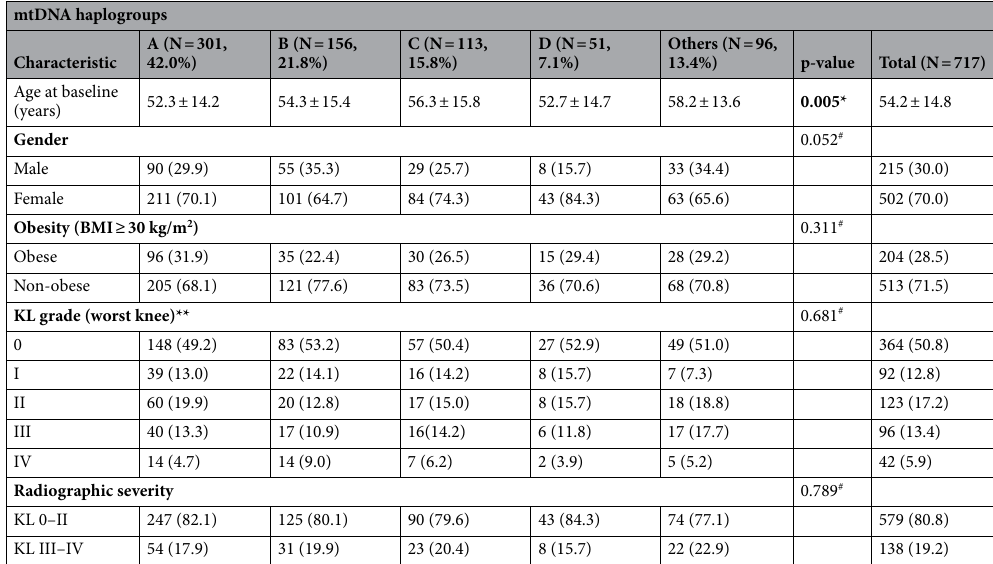
Table 1. Demographic characteristics of the study population grouped by American mitochondrial DNA (mtDNA) haplogroups. Values are mean ± standard deviation or number of patients with percentage in parentheses. BMI body mass index, KL Kellgren and Lawrence. *Kruskal–Wallis test for comparison between mtDNA haplogorups. **The worst knee is the knee with the highest KL grade; significant p-values are in bold. # Chi-square test.